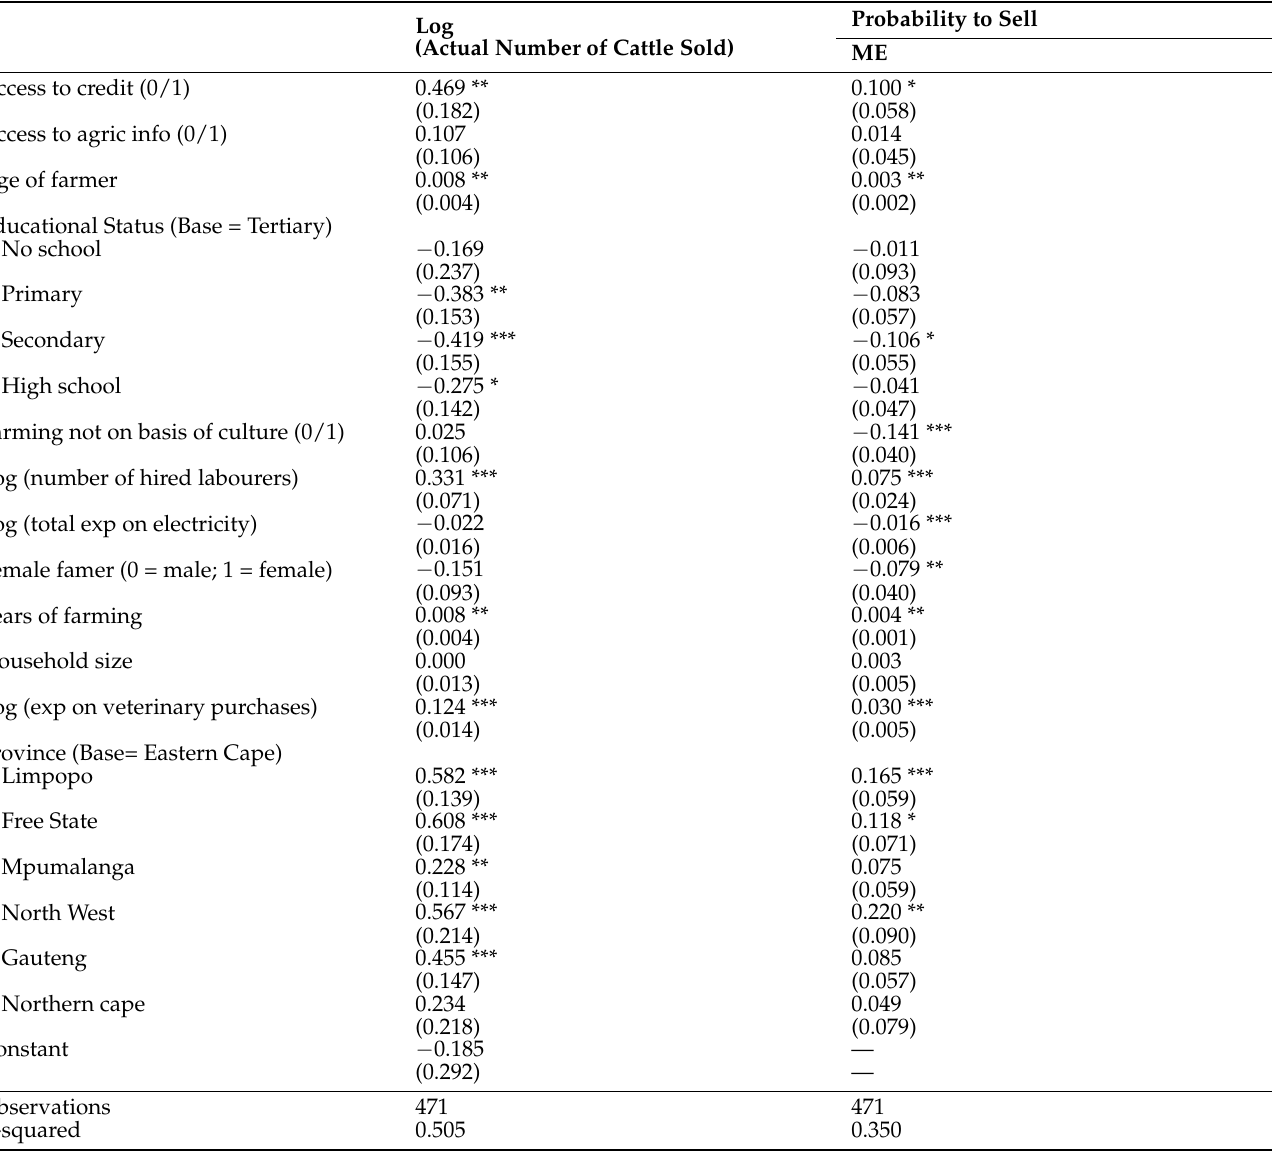
Table 4. Determinants of the number of beef cattle sold and propensity to sell per household. Log (Actual Number of Cattle Sold)